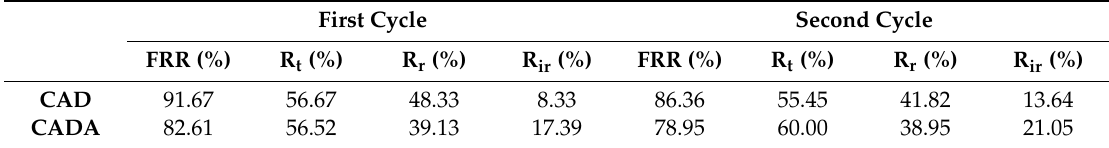
Table 6. Flux recovery ratio and resistance of CAD and CADA